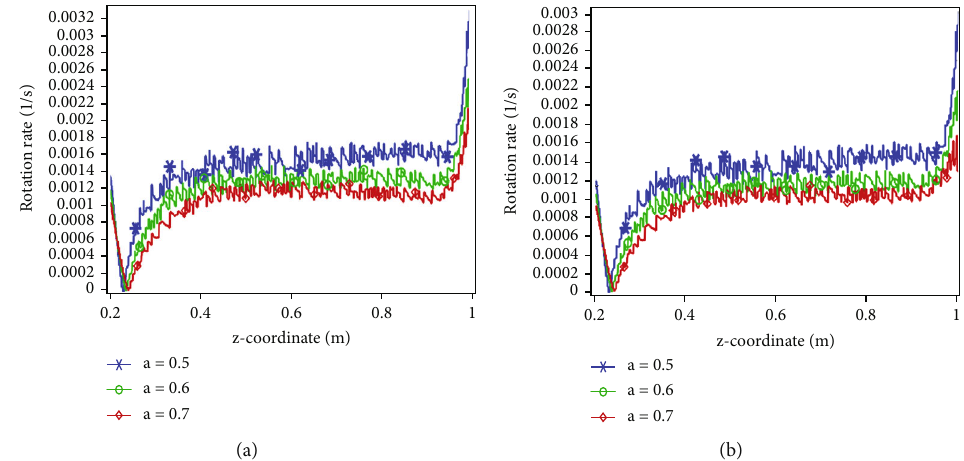
Figure 21: Measurement of rotation rate through the center middle of the downstream of backward step channel for all aspect ratios and Re = 500 : (a) I : C = 1 % and (b) I : C = 3 % .